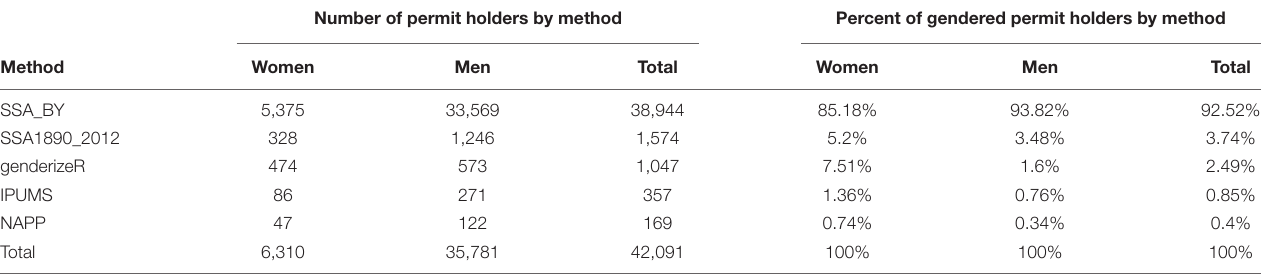
TABLE 3 | Number and percent of Alaska fishery permit holders that had gender predicted by each method. Number of permit holders by method Percent of gendered permit holders by method